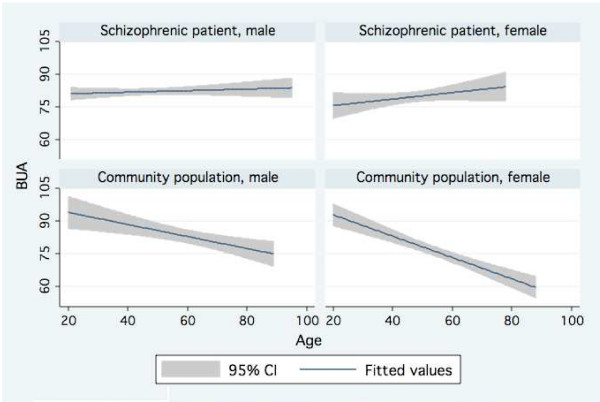
BUA vs. age with 95% confidence and fit line by subject population and sex.